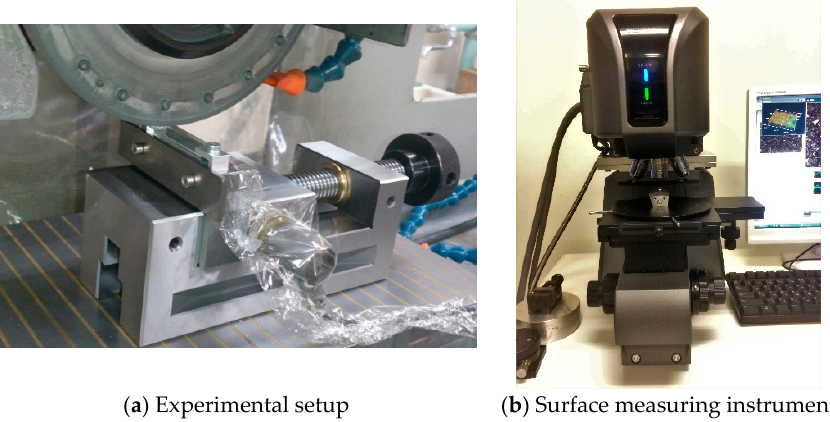
Figure 10. Experimental setup and surface measuring instrument.